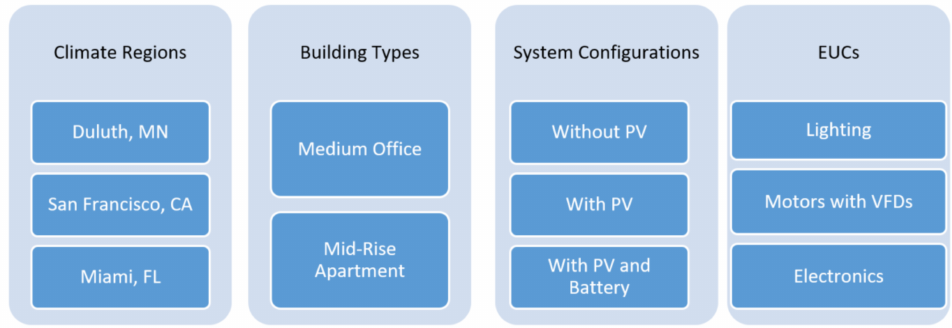
Figure 2. Summary of DC vs. AC distribution system efficiency